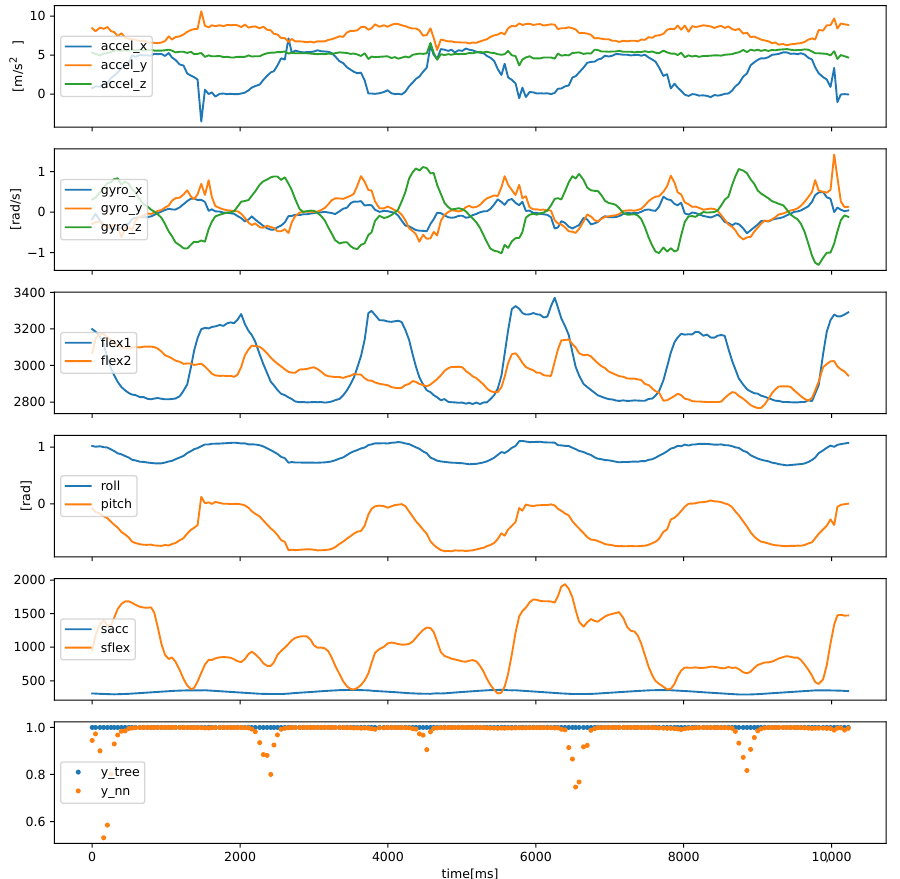
Figure 5. Data series from the sensor glove when the user is exercising correctly. Roll, pitch angles and Sacc, Sflex are computed features. The bottom graph shows the anomaly classifications (anomaly classification scores) using the neural network ( y nn ) and tree-based classifier ( y tree ). Shown is the “wrist and fingers extension” exercise from the test set.